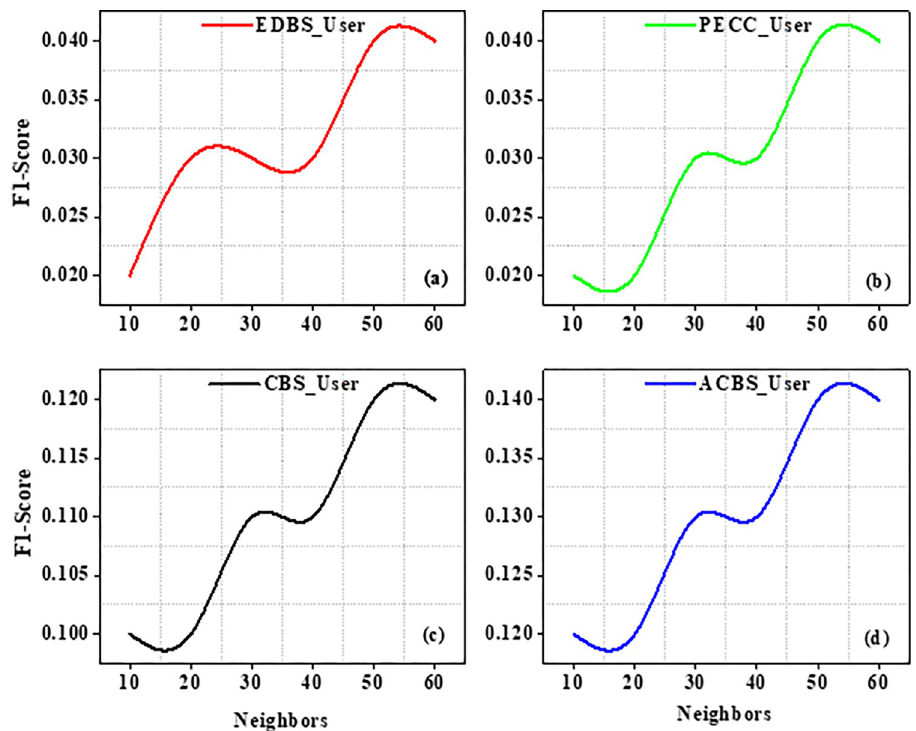
Fig 8. F1 scores with different